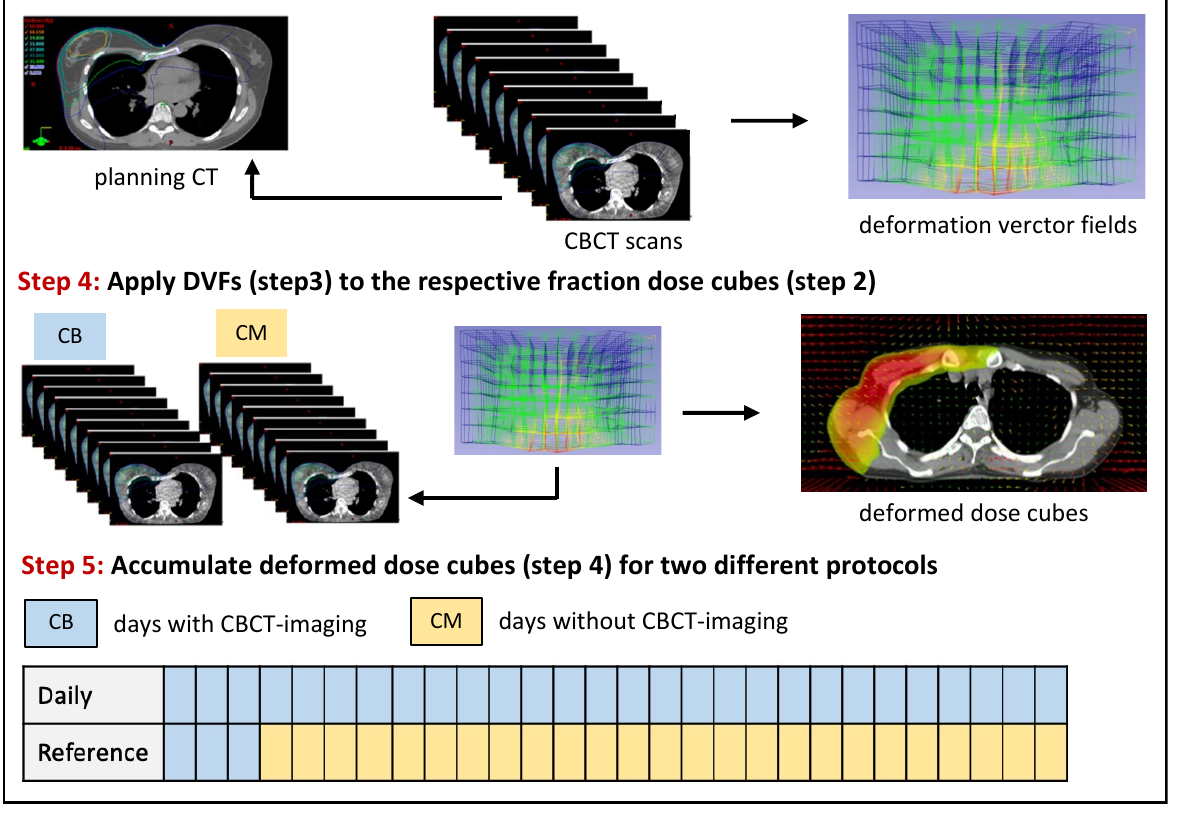
Figure 1. Dose accumulation workflow